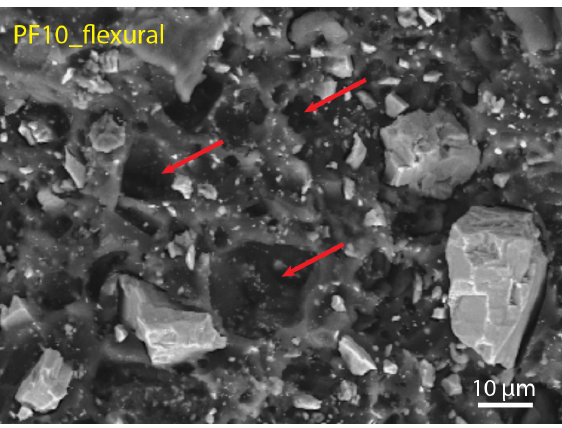
Figure 8. SE images of PF10 ( A , C ) and PT30 ( B , D ) samples showing the fracture surfaces after the flexural ( A , B ) and tensile tests ( C , D ). Figure 9 . SE image showing a close-up view of the holes (highlighted by red arrows) left by the removal of the microparticles of barite due to the applied force during the flexural test on sample PF10. The same features can be seen in all PF samples (Figures 7C and 8A,C), regardless of the presence of DCAP.